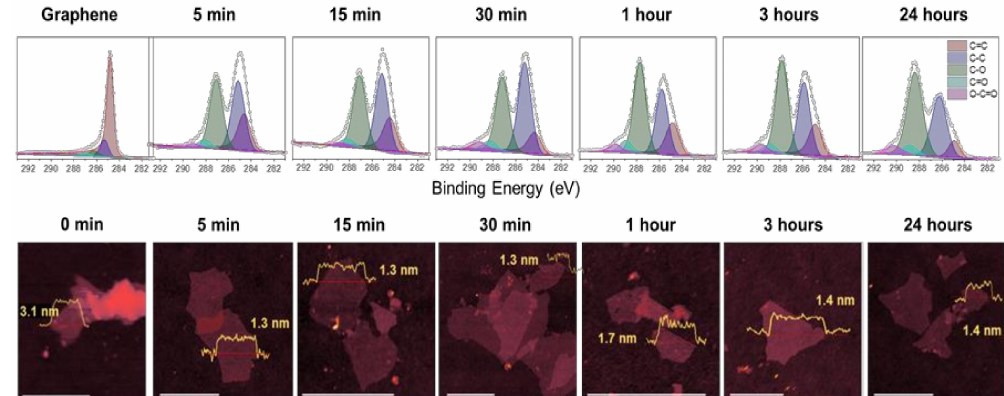
Figure 2. Characterization of graphene and GO obtained directly from graphene flakes. High resolution XPS C1s spectra for graphene and GO after 5, 15, and 30 min, and 1, 3, and 24 h with their respective atomic force microscopy (AFM) images and inset height profiles. Scales bar are 1 µ m.